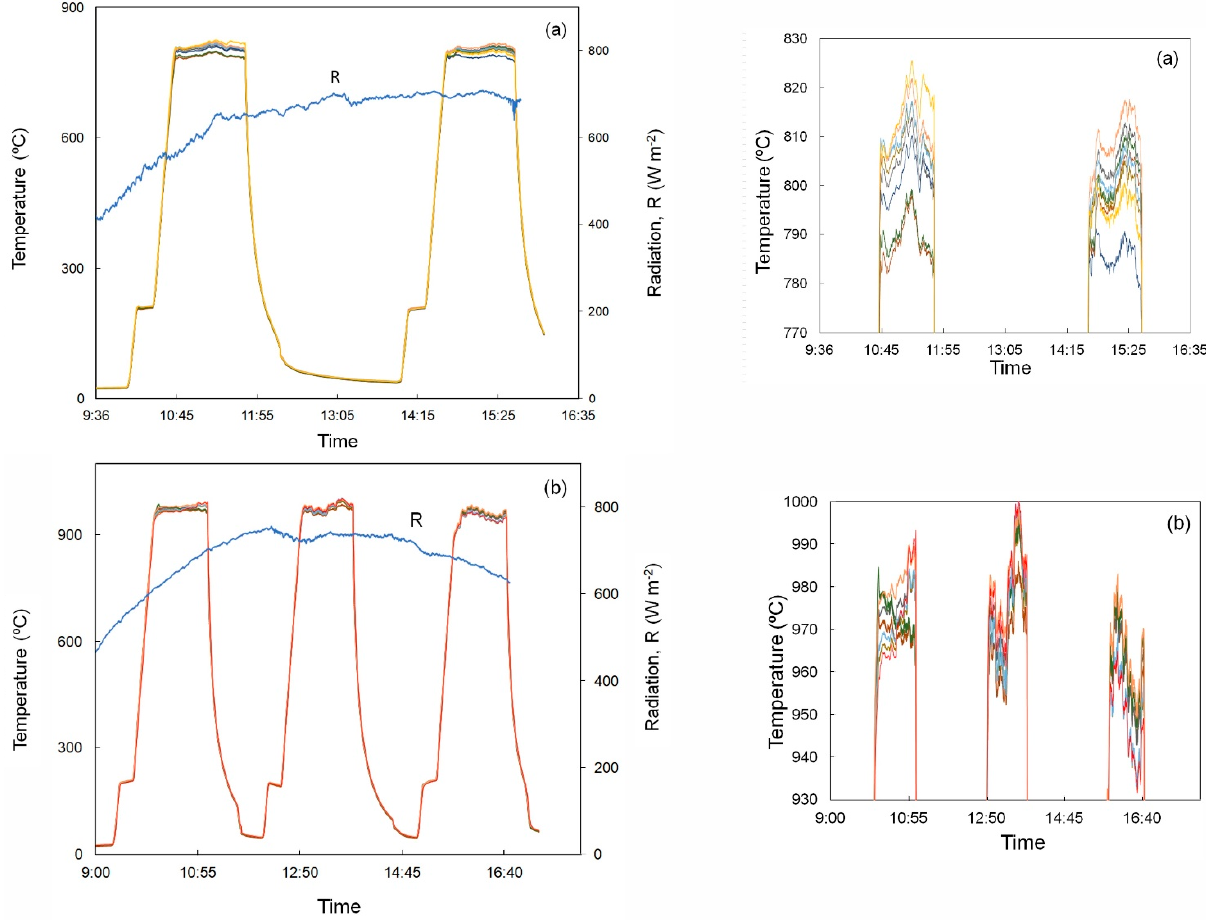
Figure 2. Temperature profiles recorded at 800 ◦ C ( a ) and 1000 ◦ C ( b ) showing data measured by the 8 K-type thermocouples placed at different heights (cf. Figure 2 in [11] and inserts) together with the solar radiation flux density measured throughout each test